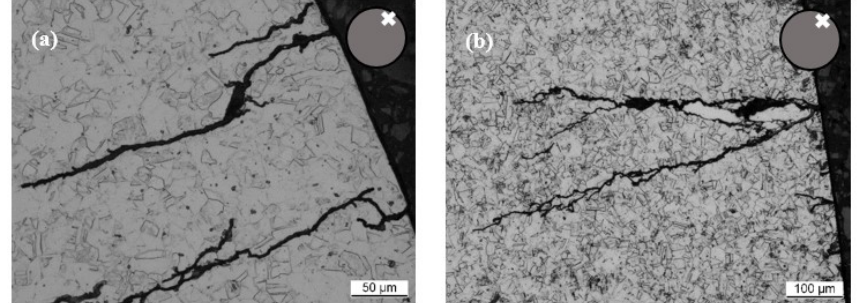
Figure 10. Light microscopic images of cross sections perpendicular to longitudinal axis through specimen loaded at 350 MPa and torsional angles of ( a ) 12.5 ◦ and ( b ) 7.5 ◦ . Note the different magnifications.